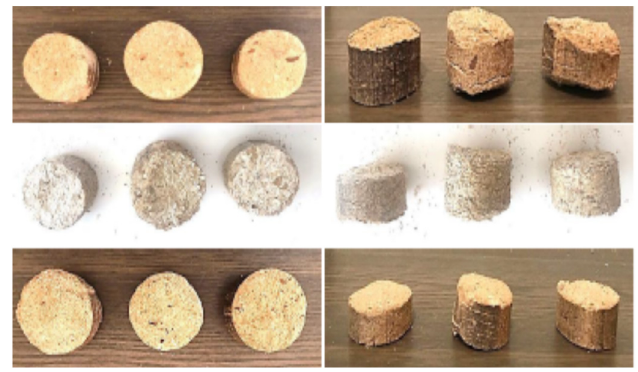
Figure 8. Bio-briquettes obtained from greenhouse wastes.